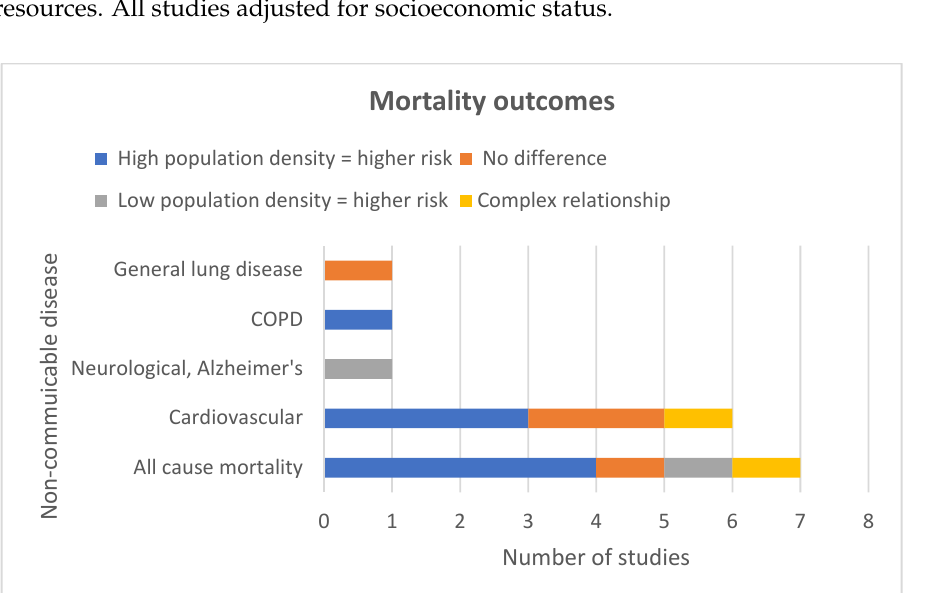
Figure 4. Cancer-specific mortality outcomes.